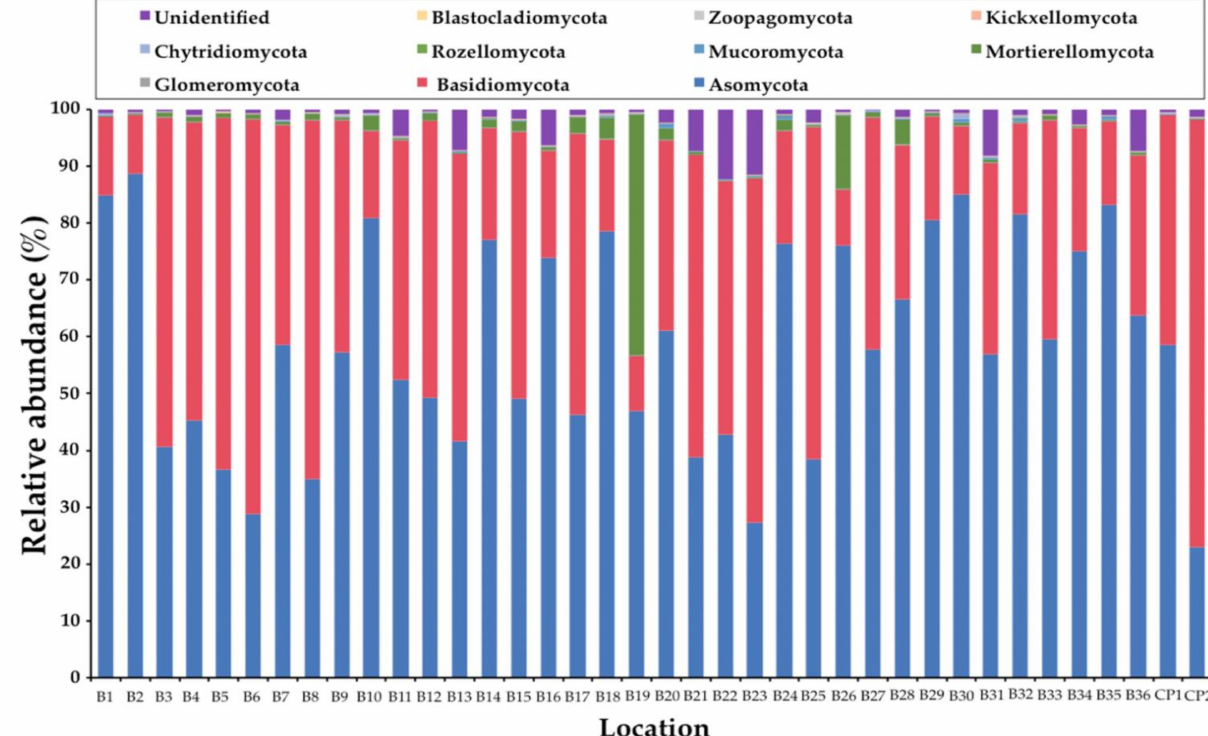
Figure 2. Soil fungal composition of each sample at the phylum level.